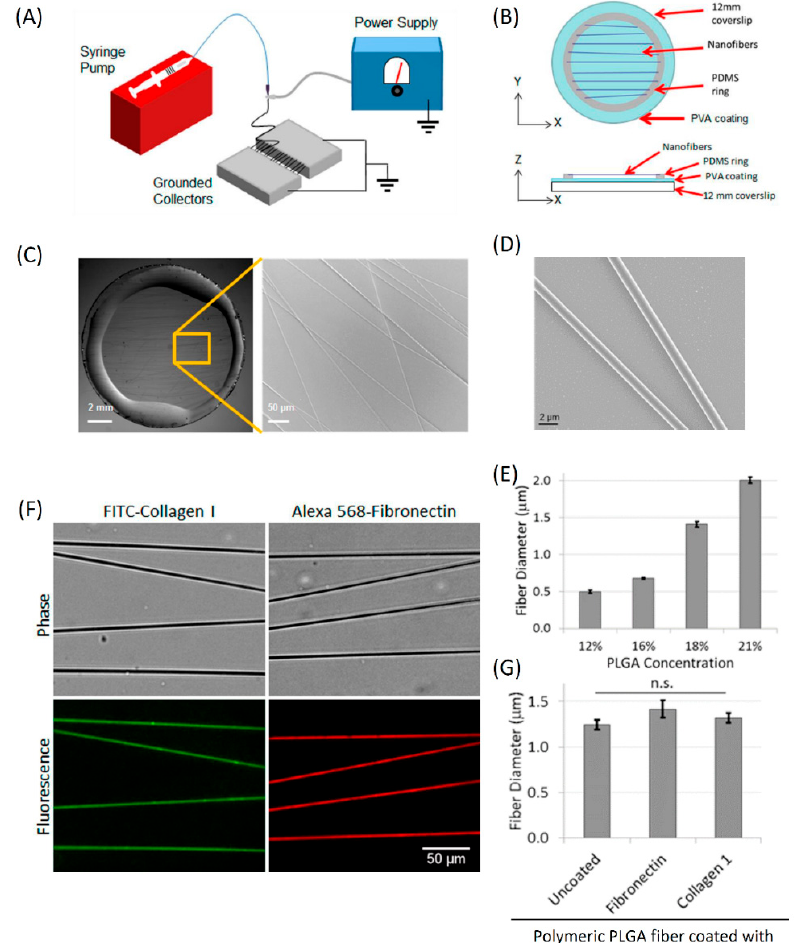
Figure 2. The in vitro 1D fiber assay setup: fabrication of PLGA fibers, their size characterization and ECM coating. ( A ) Schematic of electro-spinning technique setup for the 1D fiber generation. ( B ) A cartoon depicting the components of 1D fiber assay setup in both X-Y and X-Z views. Fibers are glued at two ends to a PDMS ring, which keeps fibers suspended in air above the PVA-coated 2D surface (cyan). ( C ) Images of 1D fibers deposited on PDMS glue ring, which keeps fibers suspended in air. Individual fibers can be seen in the zoomed view. ( D ) Scanning electron microscopy high-resolution image of 1D fibers showing cylindrical morphology of individual fibers. ( E ) Quantification of PLGA concentration vs. 1D fiber diameter using scanning electron microscopy images of fibers spun at different PLGA concentrations. Data plotted as mean ± SEM, n = 6, 10, 9, 23 fibers analyzed for 12%, 16%, 18%, and 21% PLGA concentrations. ( F ) Images of 1D fibers coated with different ECM molecules (collagen I or fibronectin), showing a uniform and selective coating of 1D fibers with no ECM deposition underneath the fibers on the 2D surface. ( G ) Quantification of 1D fiber diameter with and without different ECM coatings. Data plotted as mean ± SEM, n = 9 fibers for each